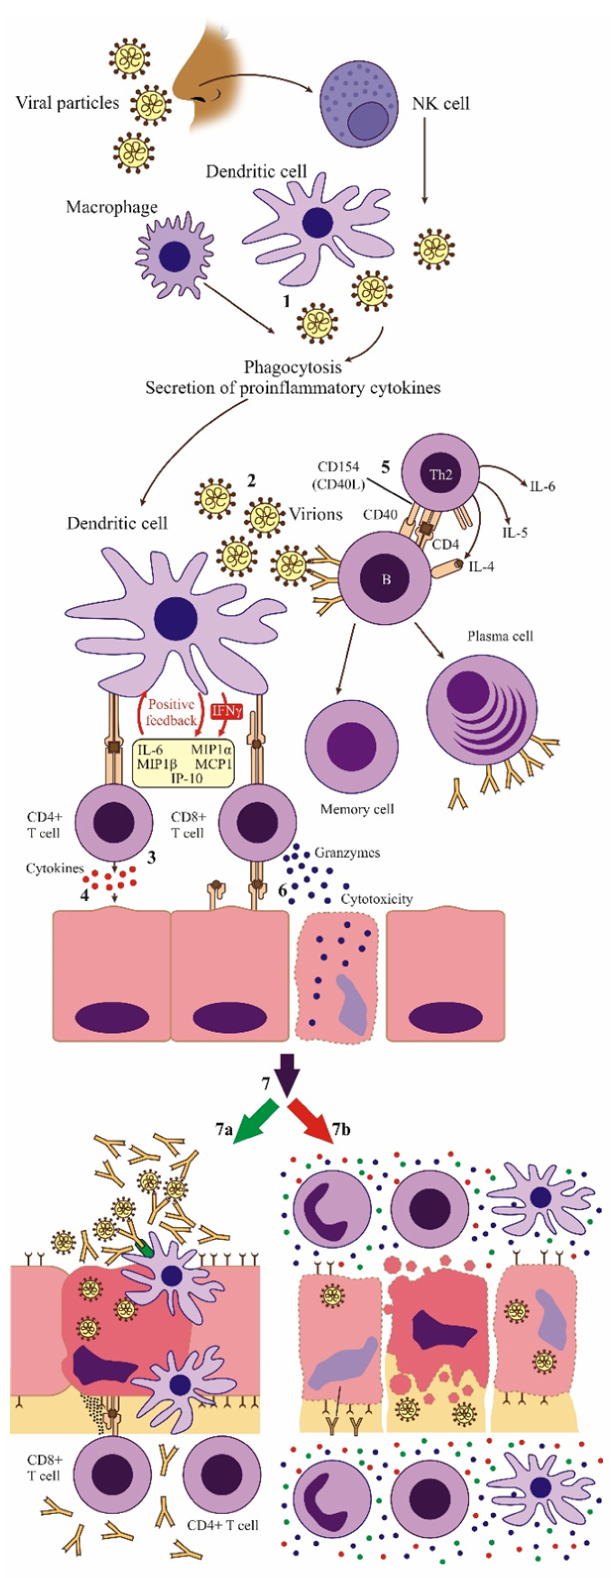
Figure 1. The evolution of the IR in SARS-CoV-2 infection. The virion (1) is recognized by innate immunity cells (1) and by the Ag receptors of Ag presenting cells (e.g., dendritic cells) (2,3) and B cells (4). After internalization and processing of virions, viral antigenic peptides are exposed on the surface of Ag, presenting cells in association with MHC I and II molecules (3). Activated CD4+ T